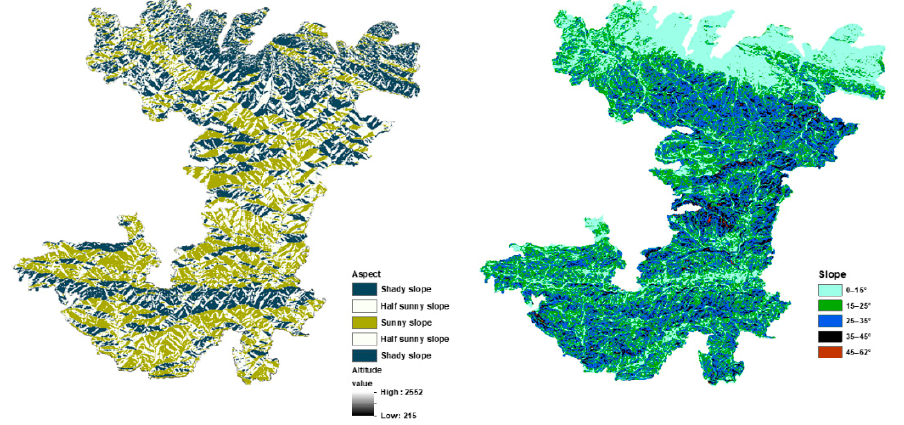
Figure 12. Slope and aspect map of the study area.